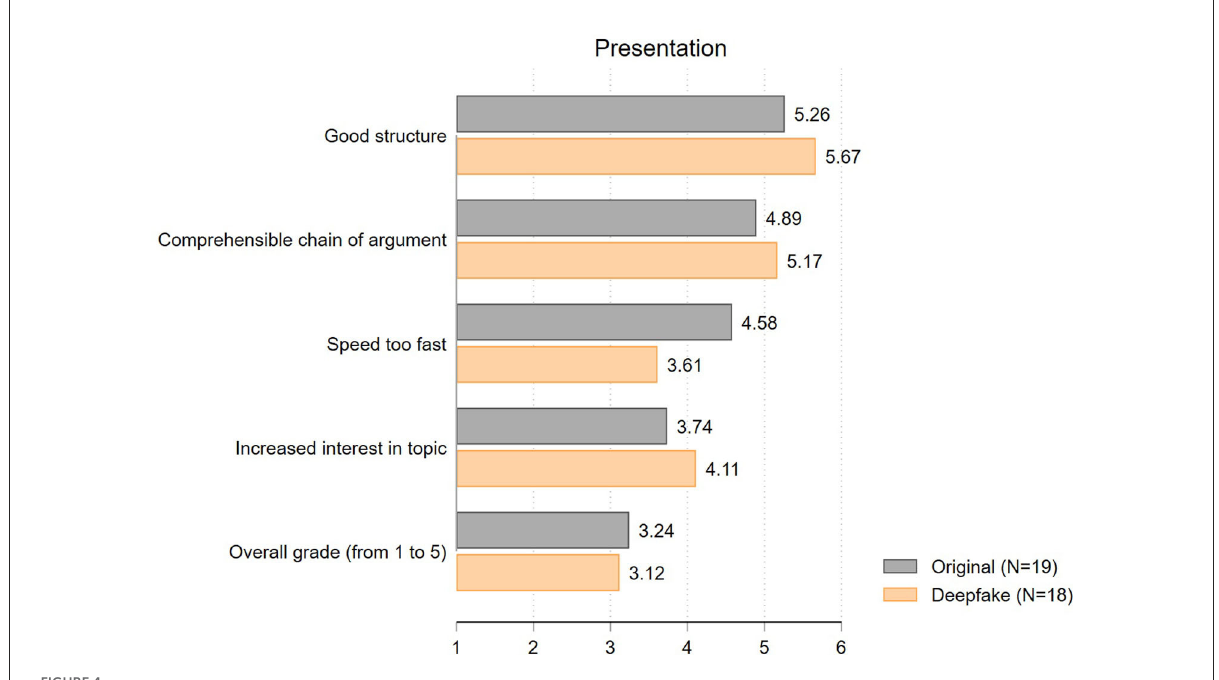
FIGURE4 Evaluation of presentation (mean